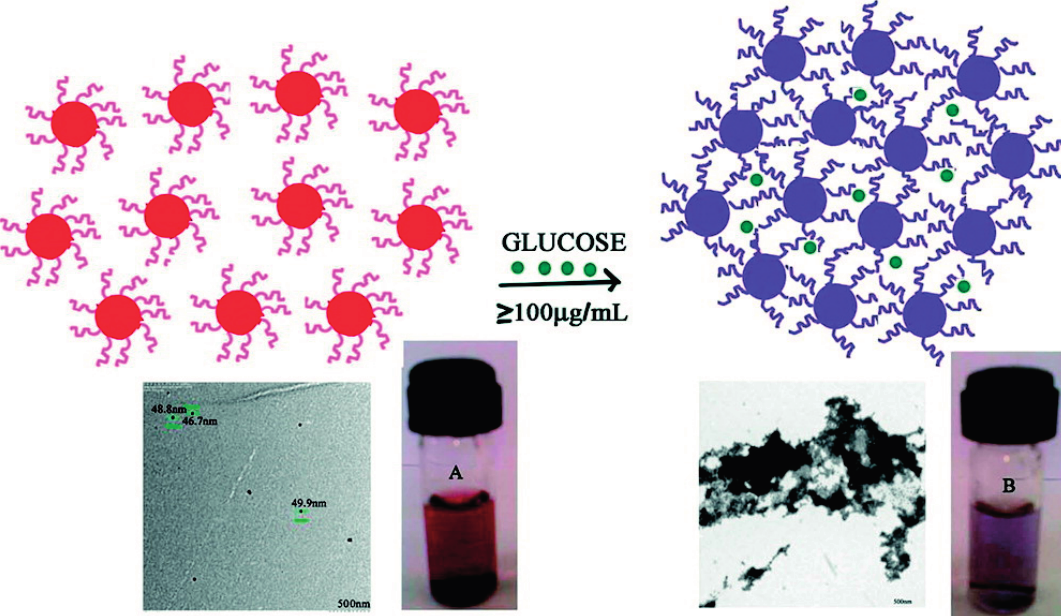
Figure 5. Color of ( A ) GNPs and ( B ) GOD-GNP on reacting with ≥ 100 μ g/mL glucose, with mechanism [190]. Reprinted with permission from (Radhakumary, C.; Sreenivasan, K. Naked eye detection of glucose in urine using glucose oxidase immobilized gold